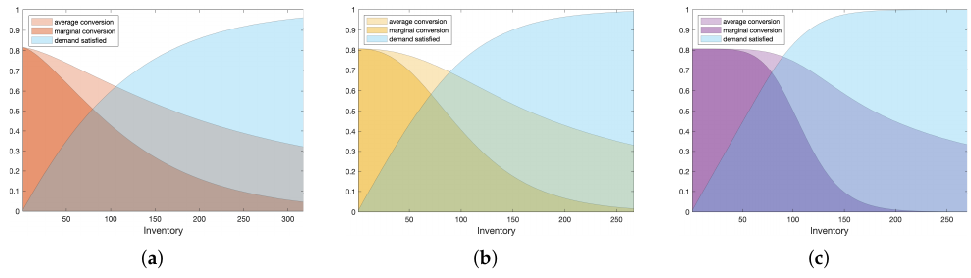
Figure 4. The curves of average conversion rate, marginal conversion rate and demand satisfied proportion related to inventory for the shoe dataset by cluster. ( a ) Cluster 1 (mean D = 106).